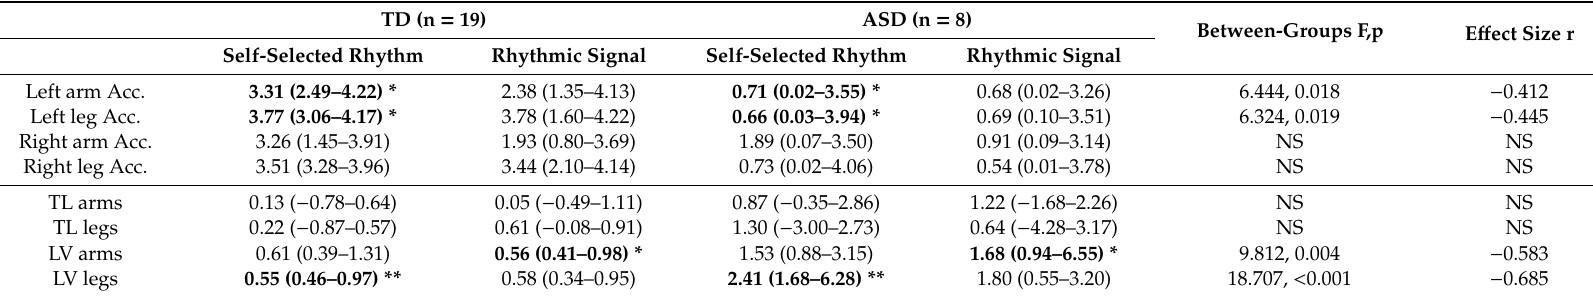
Between-Groups F,p E ff ect Size r